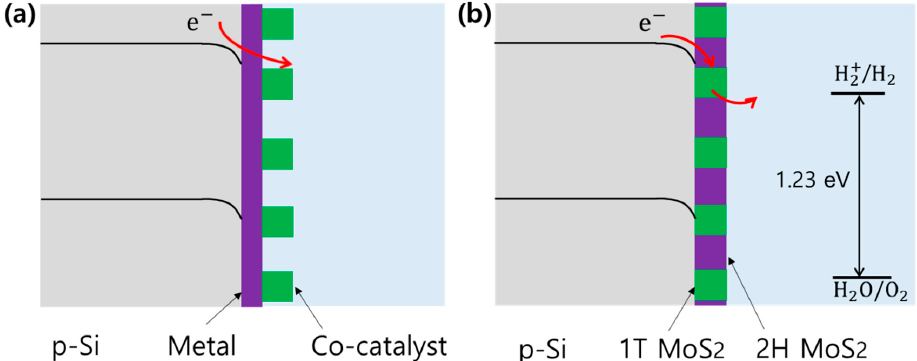
Figure 1. Device configurations of Si-based photocathodes: ( a ) Typical metal-insulator-semiconductor (MIS) Schottky junction photocathode with photocorrosion passivating and adhesion-promoting metal layers beneath the cocatalysts. ( b ) Our simple p -Si/SiO x /mixed-phase (1T/2H) MoS 2 photocathode with laterally homo and vertically heterojunctions that includes an MIS junction inside.